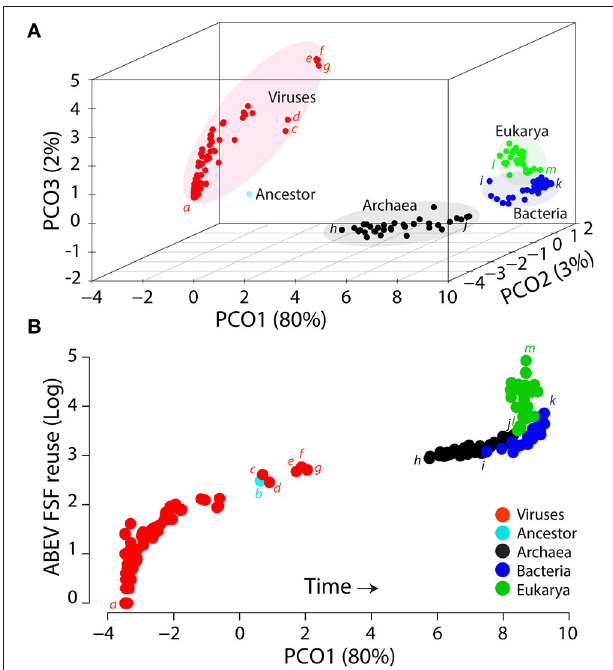
FIGURE 9 | The space of ages of FSF structural domains reveals supergroups as distinct clouds and global evolutionary tendencies of growth in proteomes. (A) An evolutionary principal coordinate (evoPCO) analysis plot portrays in its first three axes (85% variability explained) the evolutionary distances between cellular and viral proteomes [taxa = 368, characters = 442 universal FSFs, character states = occurrence * (1 − nd )]. (B) The most important evoPCO component plotted against universal ABEV FSF reuse in logarithm scale. The reconstructed proteome of the last common ancestor of modern cells was added as reference to infer the direction of evolutionary change (Kim and Caetano-Anollés, 2011 ). a , Lassa virus; b , Ancestor; c, Pandoravisus salinus ; d , Pandoravirus dulcis ; e , Acanthamoeba polyphaga mimivirus ; f , Megavirus chilensis ; g , Megavirus iba ; h , Ignicoccus hospitalis ; i , Haloarcula marismortui ; j , Lactobacillus delbrueckii ; k , Sorangium cellulosum ; l, Ashbya gossypii ; m, Emiliana huxleyi